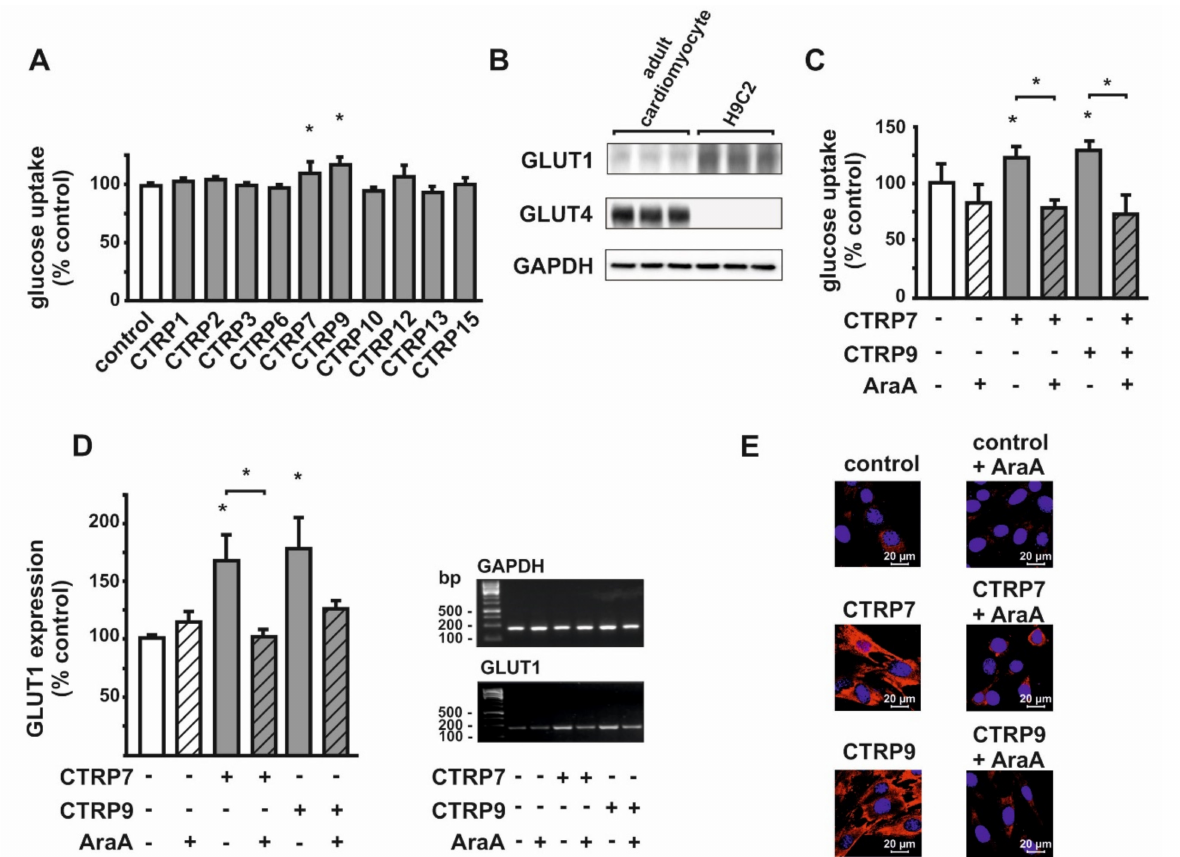
Figure 6. Glucose utilization and translocation of glucose transporter 1 (GLUT1) in response to CTRPs in H9C2 cardiomy- oblasts. ( A ) Following glucose starving for 3 h in DMEM without glucose and serum, cells were treated with CTRPs in serum-free DMEM containing 2-[ 14 C] DG for 1 h. Value was normalized to protein concentration. Data are from 5 independent experiments with 3 biological replicates, each, and are represented as mean ± SEM. * p < 0.05 vs. control. ( B ) Protein expression level of GLUT1 and GLUT4 in adult rat cardiomyocytes and H9C2 cells. ( C ) Effects of AMPK on basal and CTRP7- or CTRP9-induced glucose uptake in H9C2 cells. Data are mean ± SEM from 5 independent experiments with 3 biological replicates, each. * p < 0.05 vs. control, unless otherwise indicated. ( D ) Effects of AMPK inhibition with AraA on CTRP7- and CTRP9-induced gene expression of GLUT1. * p < 0.05 vs. control, unless otherwise indicated. ( E ) Microscopic images of the GLUT1 translocation in response to CTRP7 and CTRP9 treatment. The nucleus was stained with TO-PRO™-3 Iodide (642/661). GLUT1 was visualized with Cy3. Images are representatives of 3 independent experiments showing similar